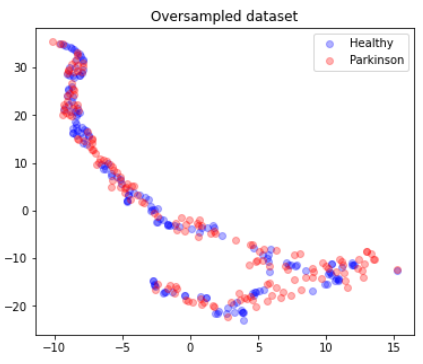
Figure 8. Oversampled dataset points distribution according to health